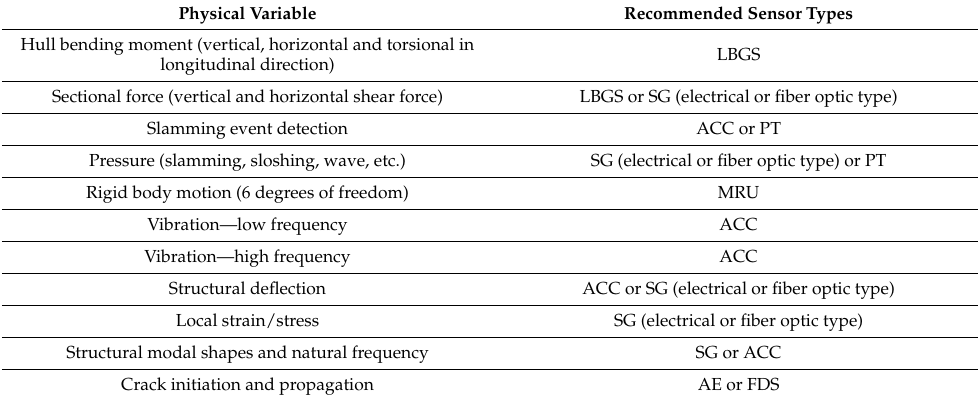
Table 2. Common physical variables and sensor types